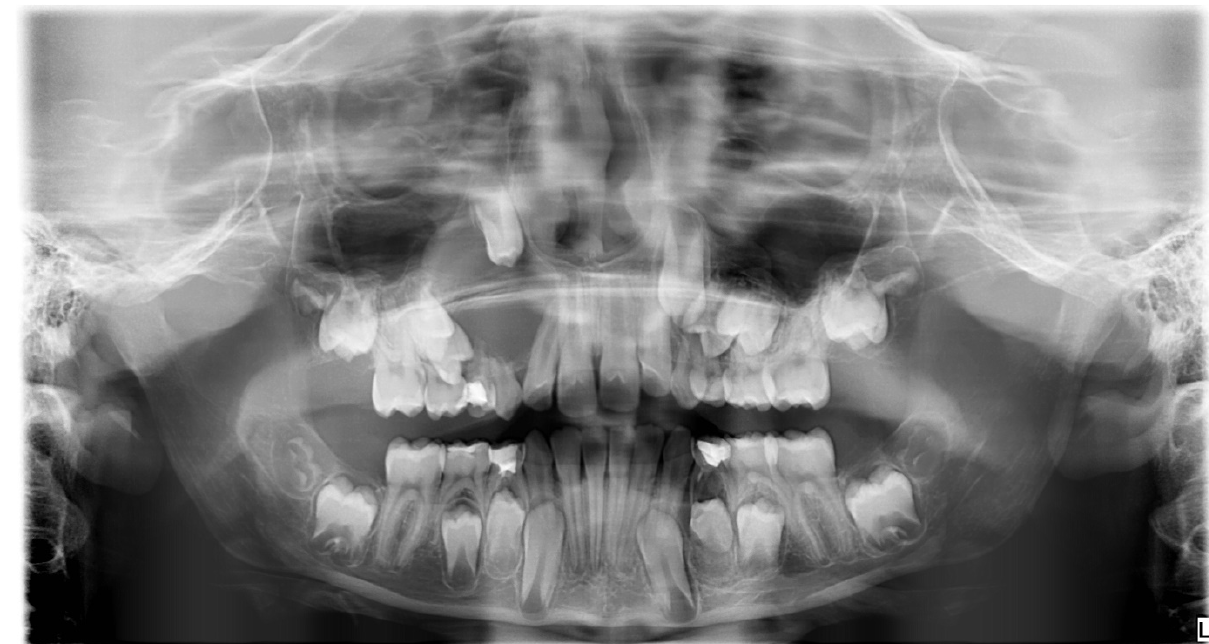
6 of 16 Figure 2. Intraoral photographs before treatment.